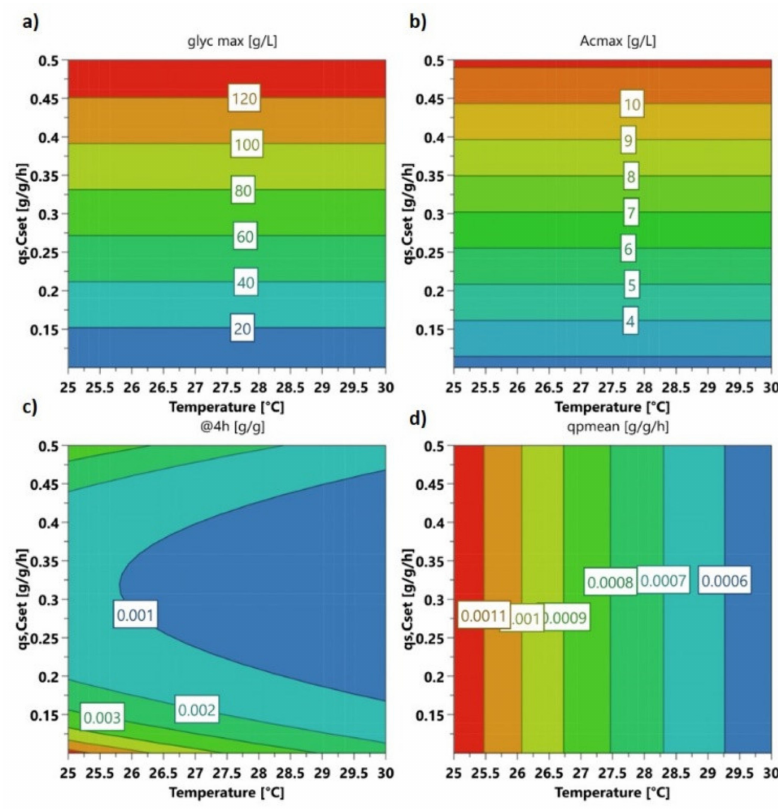
Figure 2. Contour plots. ( a ) maximum glycerol concentration in broth; ( b ) maximum acetate concentration in broth; ( c ) specific hyaluronidase IB titer at 4-h induction time; ( d ) mean specific productivity over the whole induction